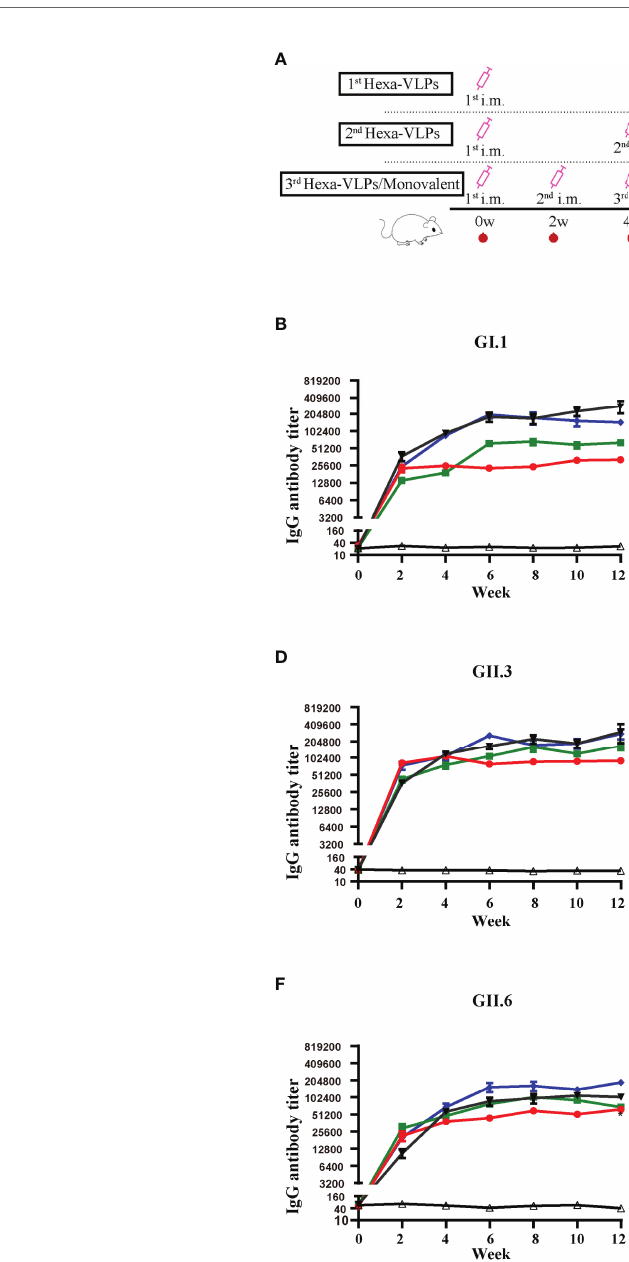
than the single-dose regimen. There were no detectable cross- blocking antibodies induced by 3 rd monovalent VLP immunized antisera, which further con fi rms the necessity of our novel multivalent vaccine ( Figure S3 ).